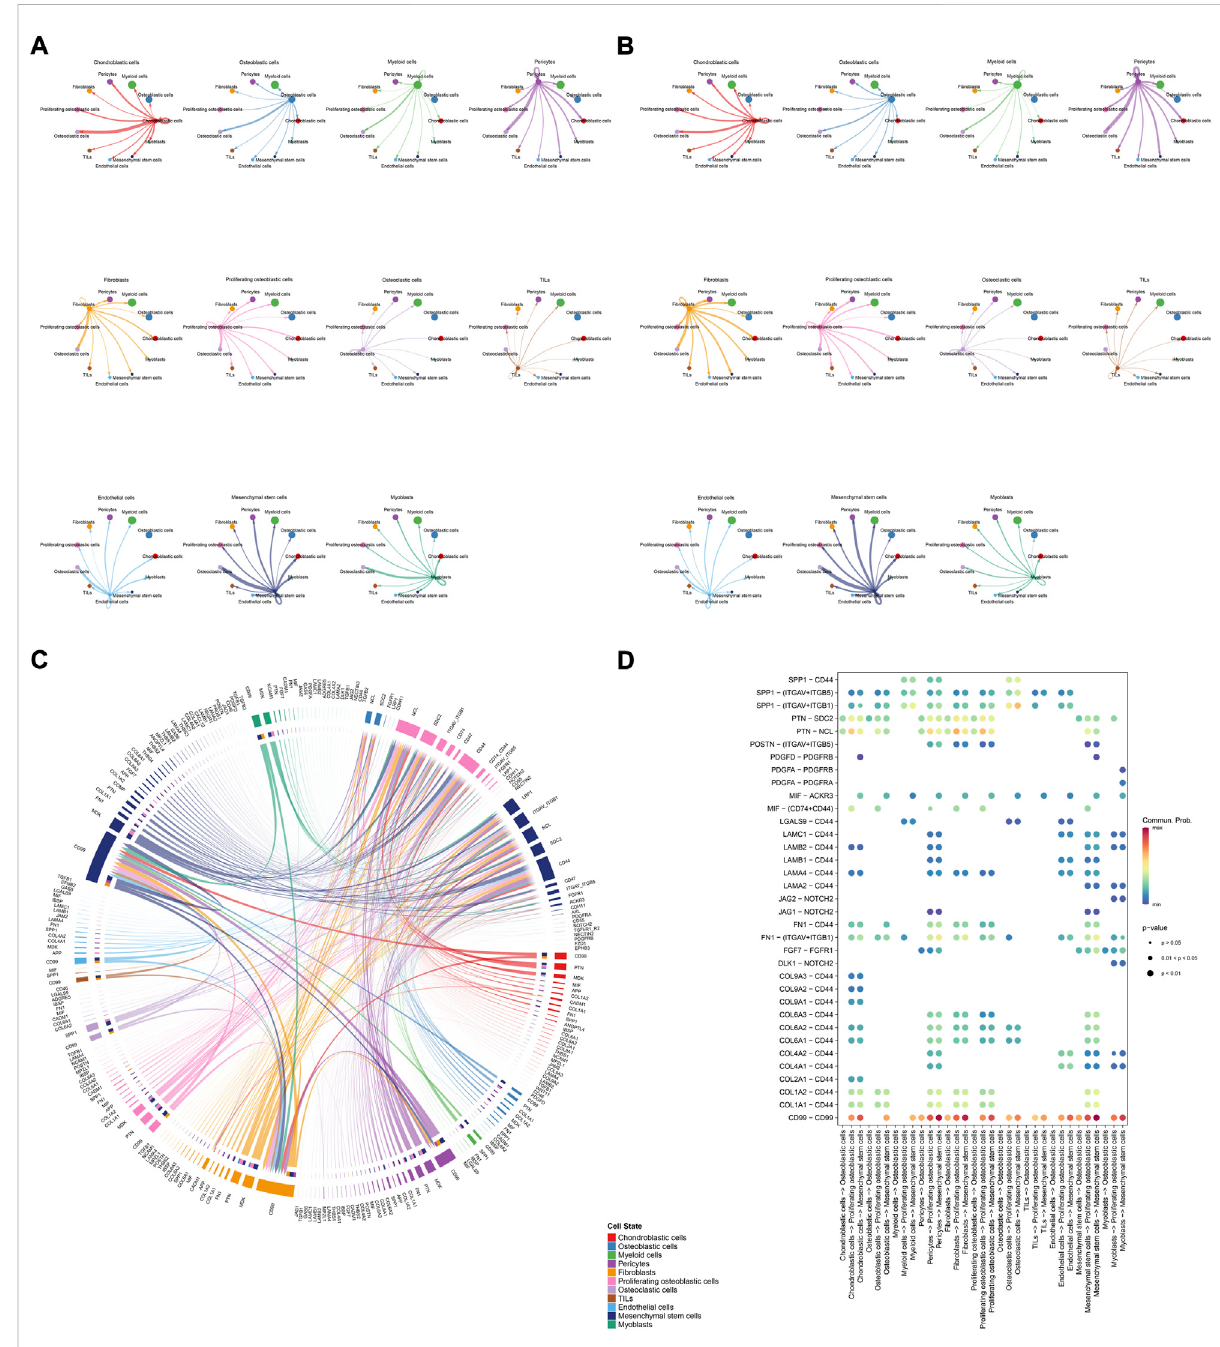
FIGURE 6 Detailed view of the ligands expressed by each major cell type. (A) : a detailed perspective of the ligands expressed by each major cell type and the cells expressing the signal-receiving receptors is provided, the thickness of the lines indicated the numbers of ligand-receptor pairs for each intercellular link. (B) : the thickness of the lines indicated the weights of ligand-receptor pairs for each intercellular link. (C) : chordal graphs showing potential cellular crosstalk within the OS microenvironment. (D) : the selected ligand-receptor interactions related to